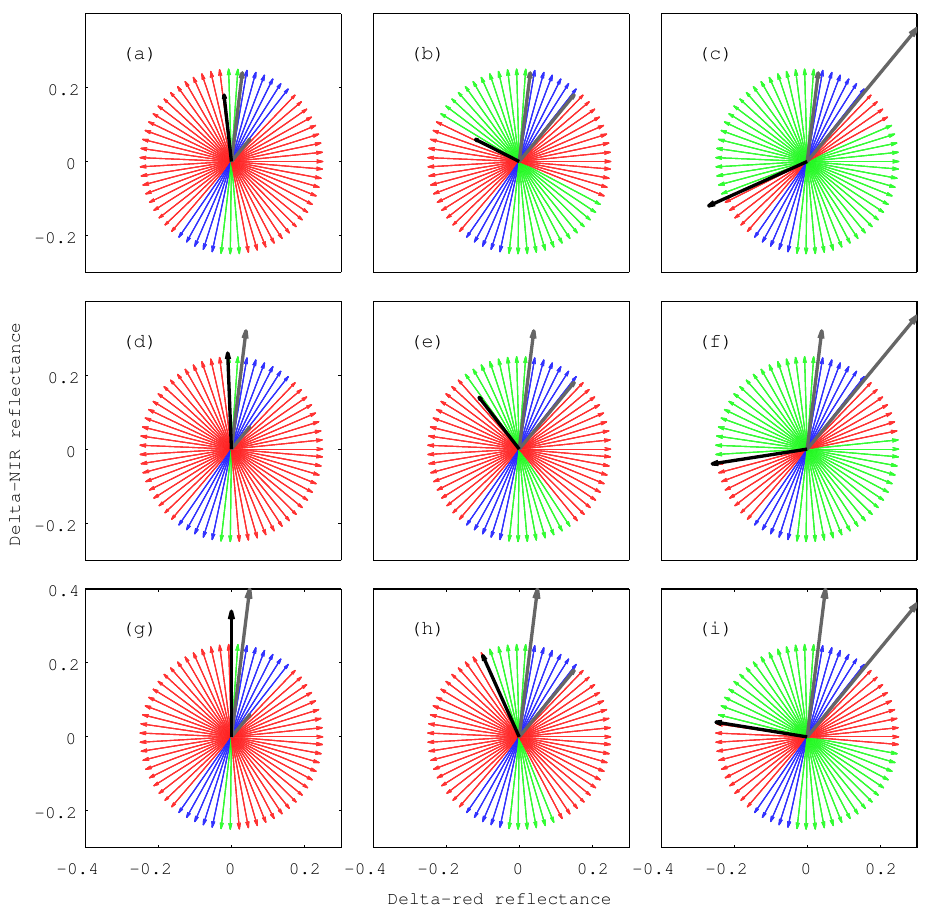
Figure 8. Results of numerical demonstration of the relationship between the endmember spectra and the monotonic behavior of the area-averaged FVC. Nine vector variations corresponding to different endmember spectra ∆ ρρρ were considered, as listed in ( a – i ) in Table 2. The vectors indicated in green correspond to non-decreasing trends in the averaged FVC ( 0 ≤ ζ < 1 ). The red arrows indicate that ζ falls into the class of non-increasing functions ( ζ > 1 ). The blue arrows indicate non-monotonic case ( ζ < 0 ). The results show the influence of the changes in ∆ ρρρ on the relation. Namely, angular ranges of each colored vector (trends in averaged FVC along spatial resolution) vary with ∆ ρρρ